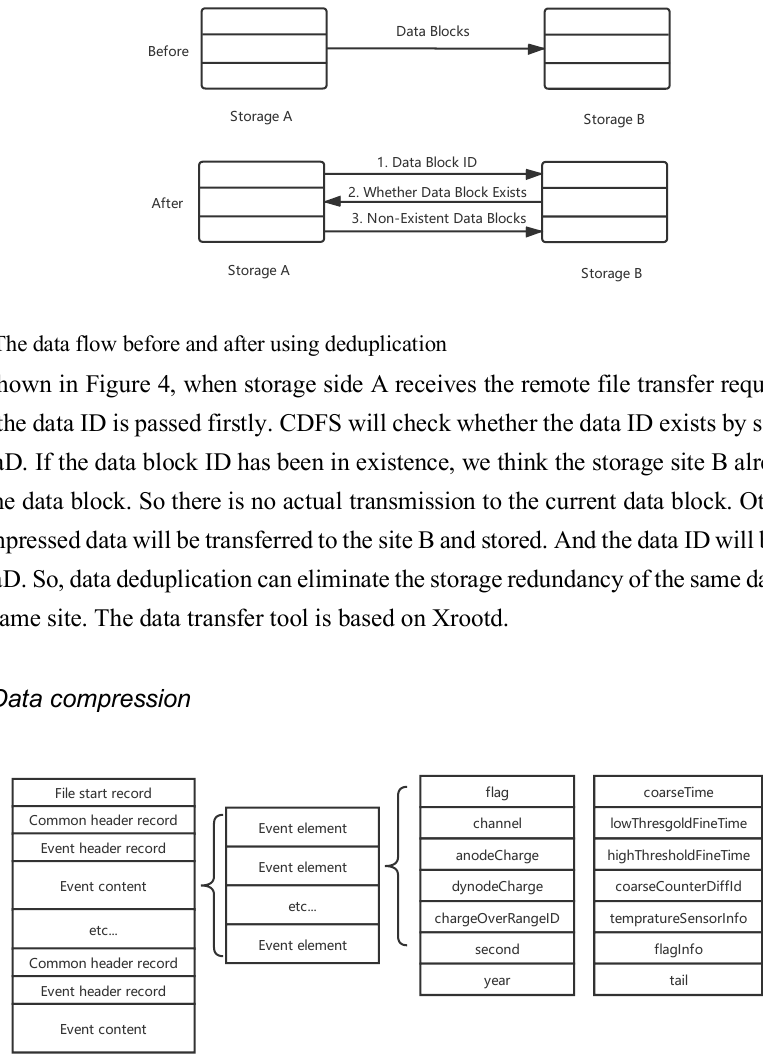
Fig. 5. The structure of WCDA